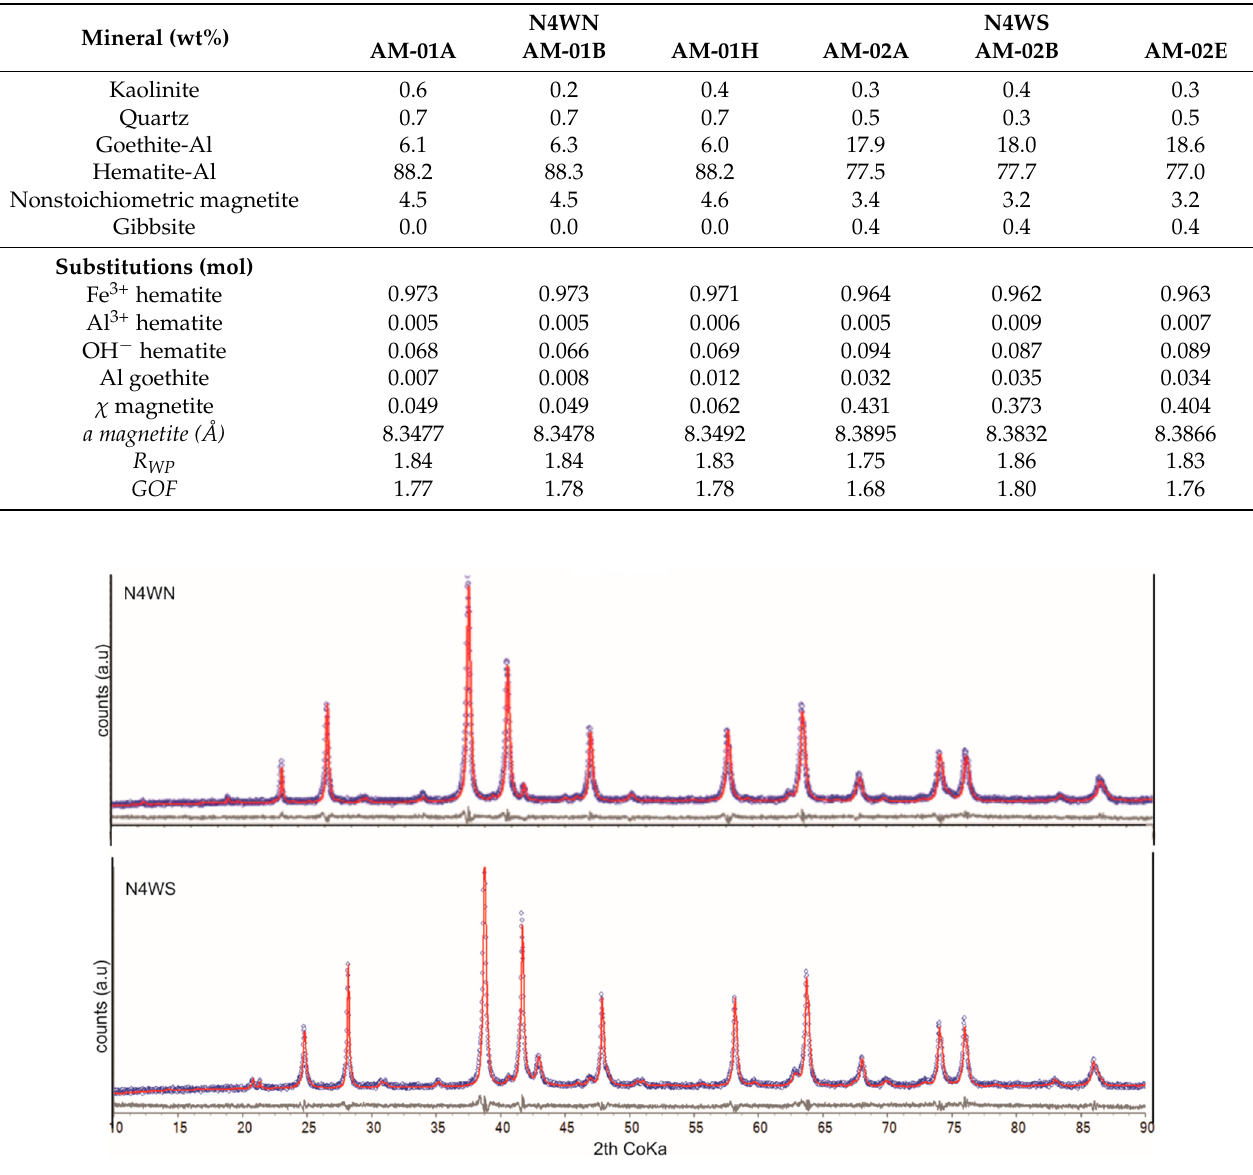
Table 4. Rietveld quantitative phase analysis, substitutions, and magnetite stoichiometry ( χ ) for iron ores from Caraj á s.